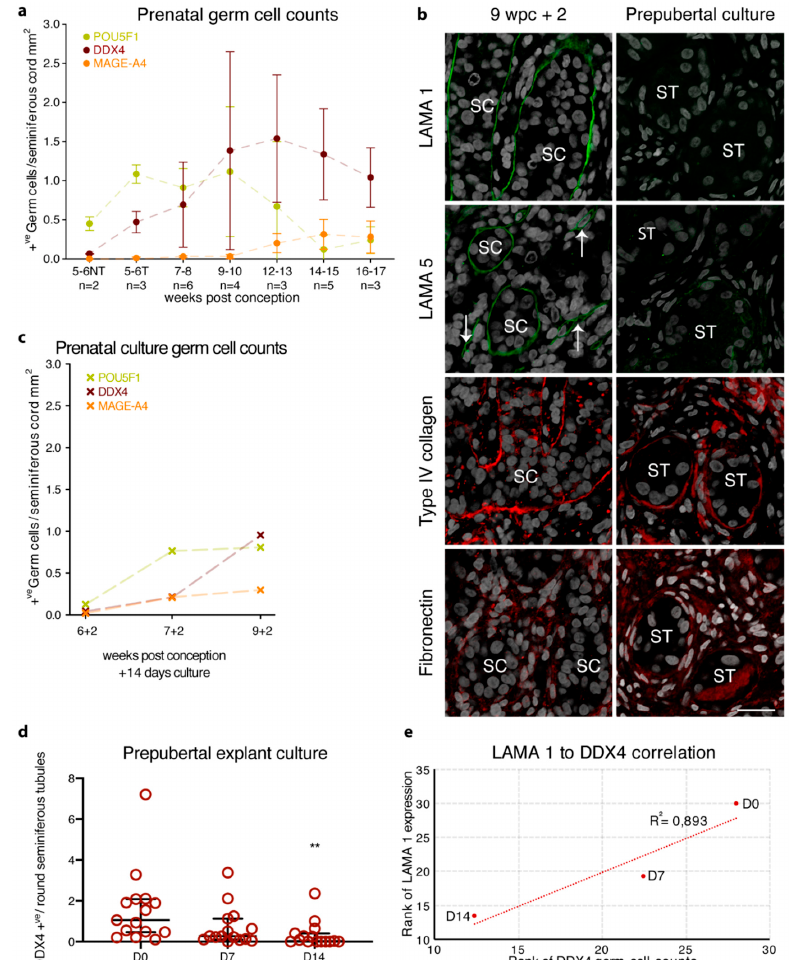
Figure 4. Basement membrane expression of prenatal, prepubertal, and peripubertal tissue cultures in correlation to germ cell loss. ( a ) Prenatal germ cell counts for POU5F1 (green), DDX4 (dark red), and MAGE-A4 (orange) are presented as the mean ± SD of positive germ cells per seminiferous cord mm 2 from 5 to 17 weeks post conception. NT represents samples with not yet formed seminiferous cords; T represents samples with formed seminiferous cords. ( b ) Following culture for 14 days, the prenatal gonadal tissue shows seminiferous BM expression of LAMA 1 (green staining) and LAMA 5 (green staining), while type IV collagen (red staining) and fibronectin (red staining) show seminiferous BM and interstitial expression. The 14-day pre- and peripubertal testicular cultures show the loss of LAMA 1 expression and weak seminiferous BM expression of LAMA 5 with the seminiferous BM and interstitial expression of type IV collagen and fibronectin. Counterstain with DAPI (grey staining). SC depicts the seminiferous cord, white arrows indicate blood vessels, scale bar: 25 µ m ( c ) POU5F1 (green), DDX4 (dark red), and MAGE-A4 (orange) germ cell counts for the prenatal tissue culture are presented as positive germ cells per seminiferous cord mm 2 for three prenatal culture samples. ( d ) Number of DDX4 positive germ cells per seminiferous tubule cross-section from 16 patients. Median, fifth, and 95th percentile of DDX4 counts are shown for control (D0), D7 and D14 of culture. ** Indicate p < 0.01 significance between D0 and D14. ( e ) Spearman’s correlation of DDX4 positive germ cells per seminiferous tubule cross-section in relation to LAMA 1 positive seminiferous tubules for prepubertal explant cultures at D0 ( n = 13), D7 ( n = 12), and D14 ( n =